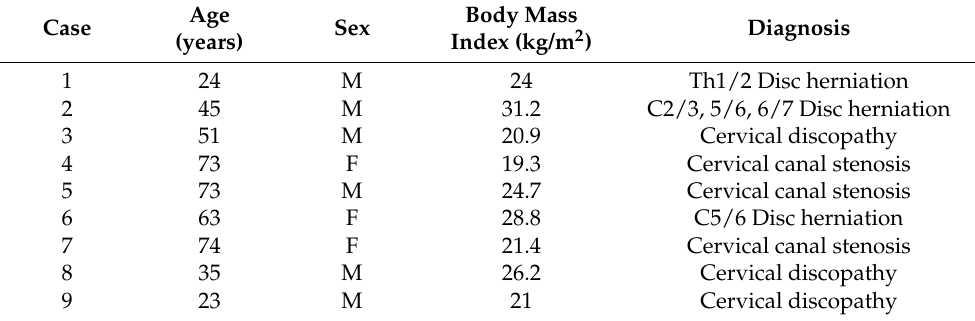
Table 1. Clinical and demographic characteristics.